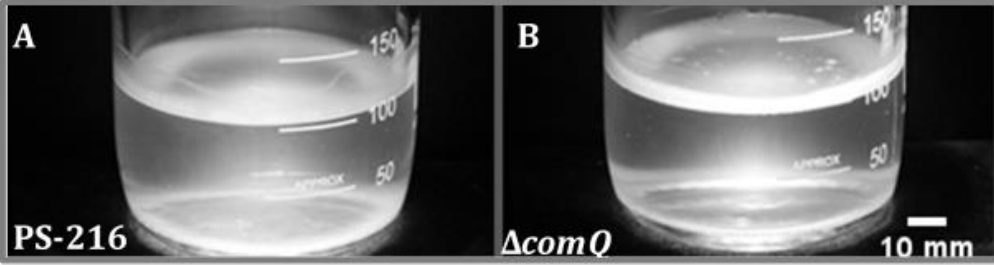
Figure 1. Pellicle biofilms of the Bacillus subtilis wild type PS-216 ( A ) and the ComX deficient PS-216 Δ comQ strain (BM1127) ( B ) grown statically in MSgg medium at 37 °C and in 250 mL bottles for 16 h.